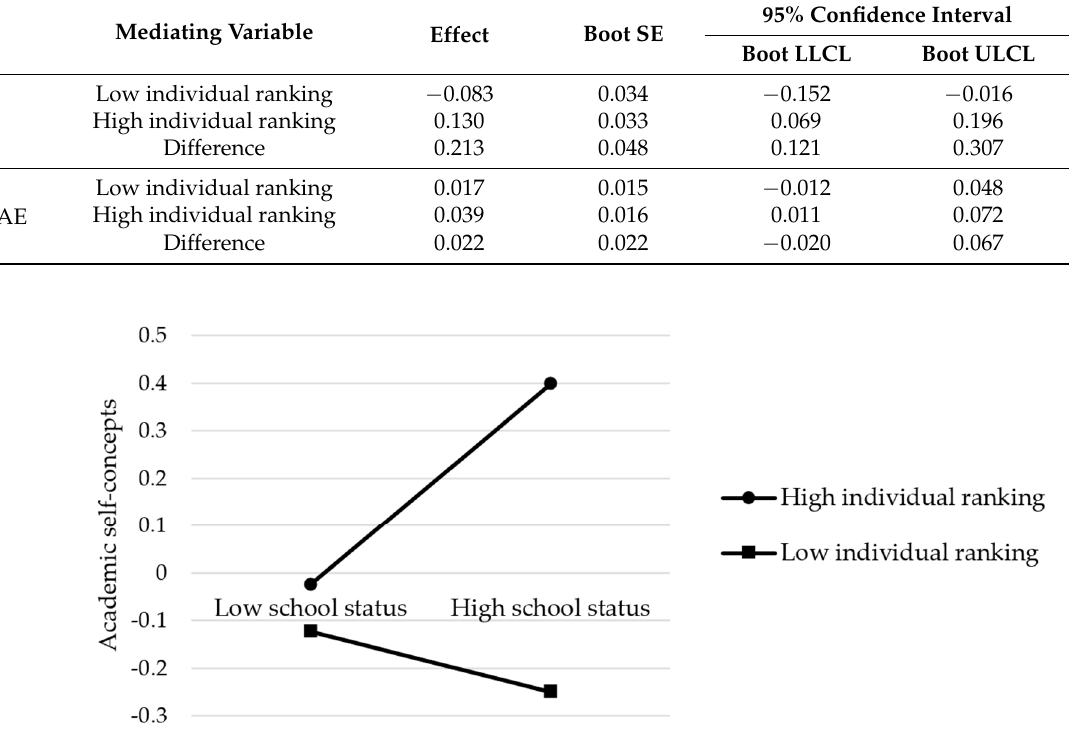
Figure 3. A diagram of the moderated serial mediation model, with positive achievement emotions as the dependent variable. SS—school status; SB—sense of school belonging; ASC—academic self- concepts; PAE—positive achievement emotions; IR—individual ranking; * p < 0.05; ** p < 0.01. Table 5. Moderated serial mediation results, with positive achievement emotions as the dependent variable. SS—school status; SB—sense of school belonging; ASC—academic self-concepts; PAE— positive achievement emotions.